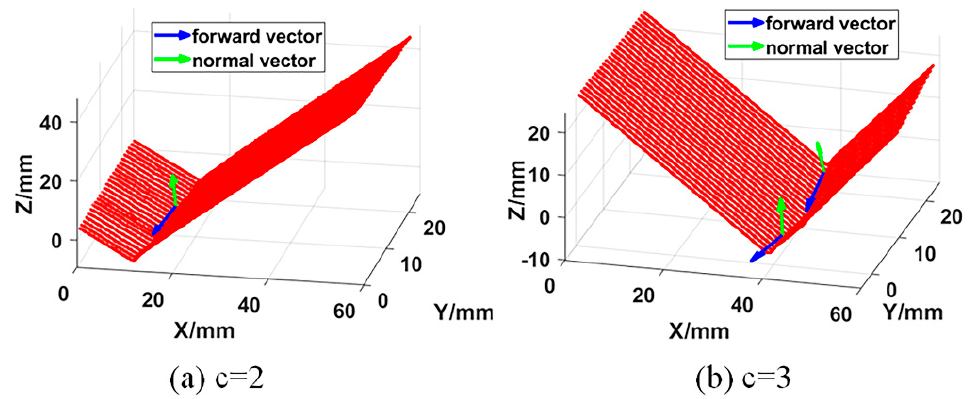
Figure 9. Welding seam attitude estimation results; ( a ) When c = 2, the welding seam attitude esti- mation result; ( b ) When c = 3, the welding seam attitude estimation result.